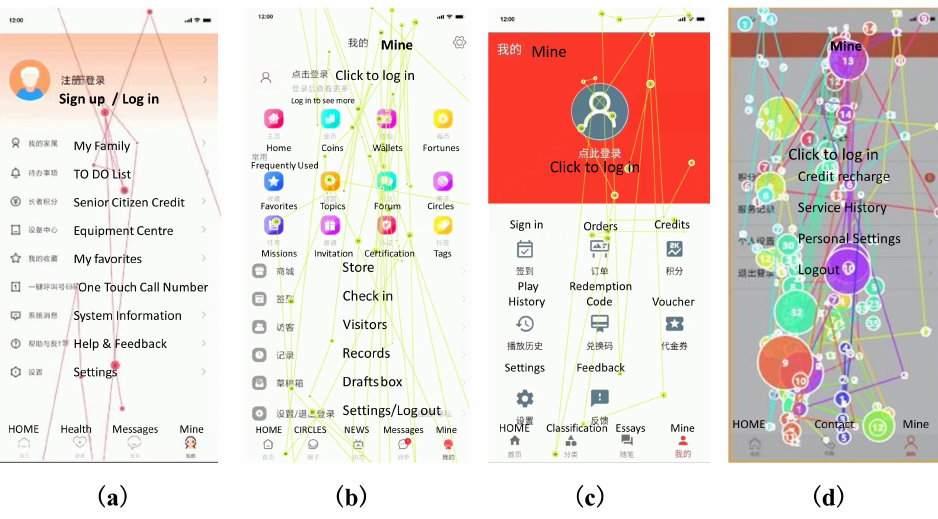
Figure 6. Four product eye movement track maps: ( a ) C-Life Senior Care APP login screen track diagram; ( b ) Senior Living APP login screen track diagram; ( c ) Senior Care Manager APP login screen track diagram; ( d ) Smart Aging APP login screen track